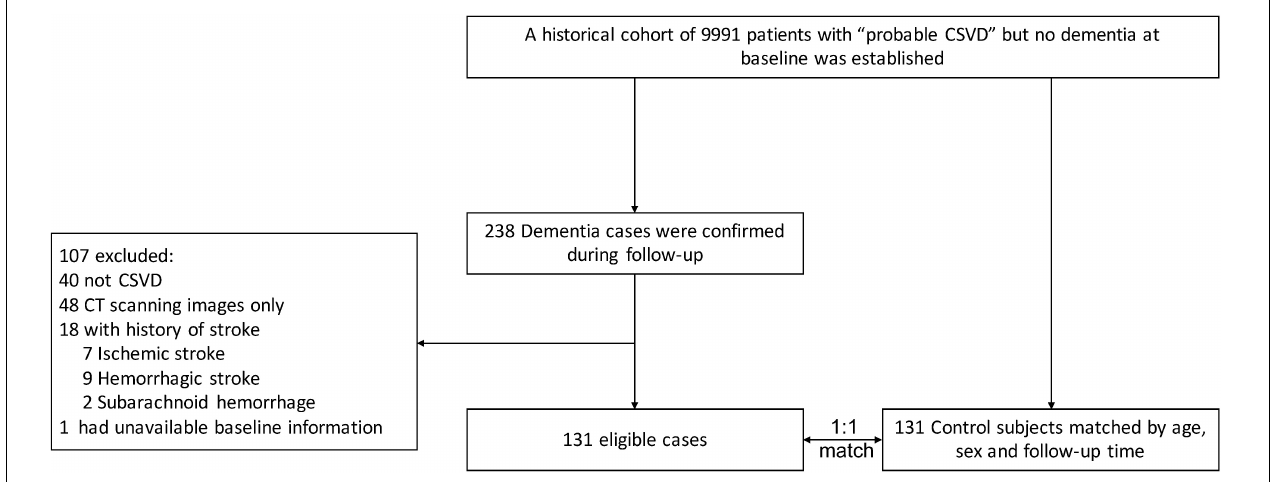
FIGURE 1 | Study flowchart. The CSVD diagnosis of each patient, both in the case and control groups, was re-confirmed by neurologists and radiologists. CSVD, cerebral small vessel disease; CT, computed tomography.